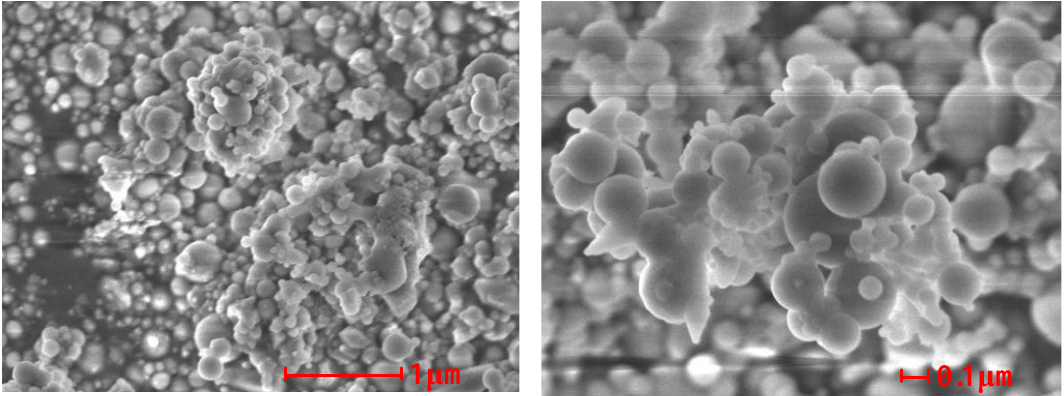
Figure 8. SEM photographs of the cross-sectional structures of Sample 2.